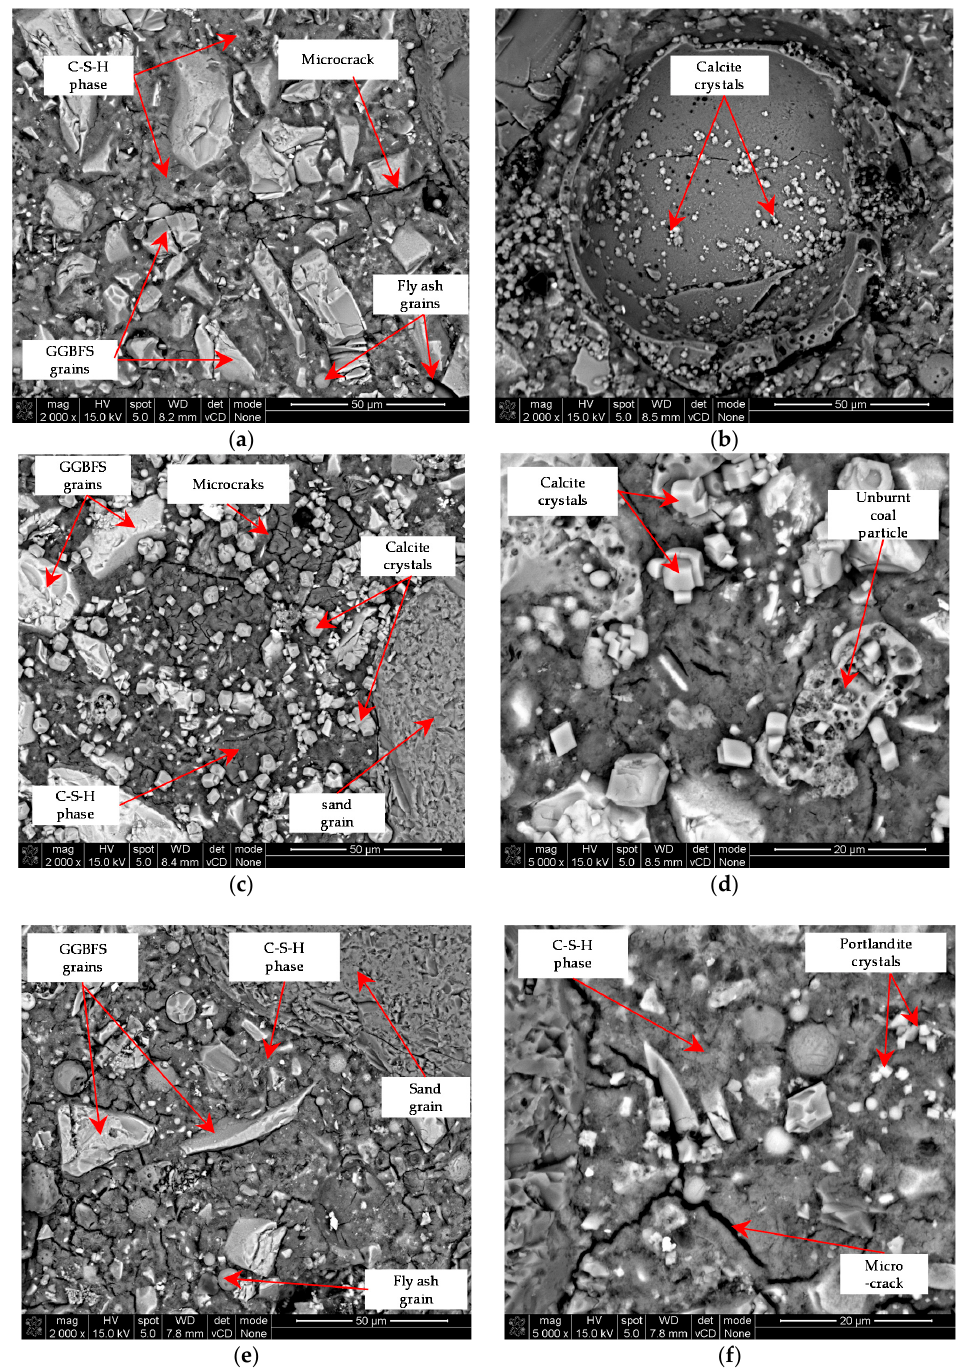
Figure 7. SEM images (BSE) presenting the microstructures of the ( a , b ) C55_SFA15_SF3, ( c , d ) C100_SFA15_SF3, and ( e , f ) C100_SFA30_SF3 samples.